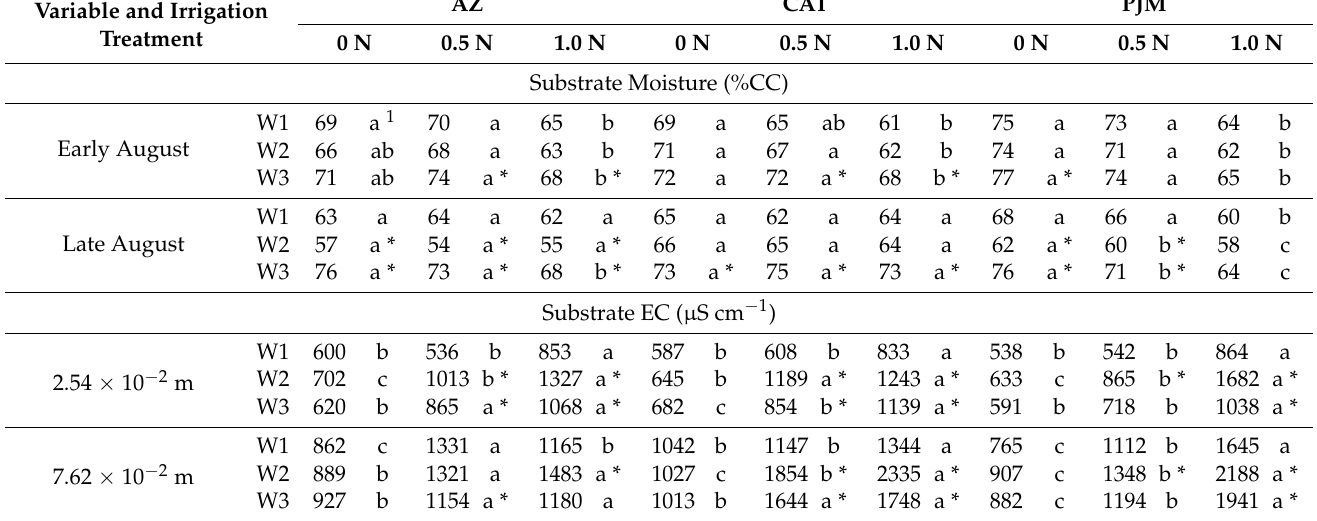
Table 3. Substrate moisture and electric conductivity (EC) in ‘Gibraltar’ (AZ), ‘Catawbiense Album’ (CAT), and ‘P.J.M.’ (PJM) Rhododendron . In Year 1, plants from each cultivar were grown in soilless media with N-free fertilizer (0 N) or N-free fertilizer plus 7 (0.5 N) or 14 (1.0 N) mg N per day